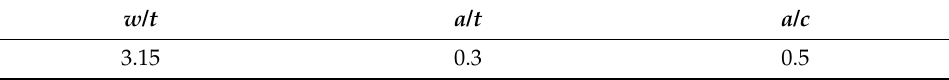
Figure 2. Structural schematics considered in crack tip meshing strategies: ( a ) A flat plate with a surface crack; ( b ) Shape parameters of semi-elliptical surface crack. Table 1. Shape variables of plates with semi-elliptical surface crack .